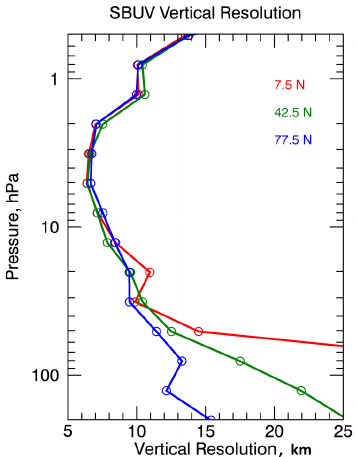
Fig. 9. SBUV vertical resolution estimated from the diagonal el- ements of the SBUV averaging kernels for three different lat- itude zones: tropics (5–10 ◦ N, SZA=27 ◦ ), mid-latitudes (40– 45 ◦ N, SZA=26 ◦ ), and high latitudes (75–80 ◦ N, SZA=57.5 ◦ ) for NOAA-17 for July 2004. The SBUV vertical resolution is about 6–7km between 10 and 2hPa and degrades above and below this range. The vertical resolution is similar for all latitude bands be- tween 20hPa and 0.5hPa. Below 20hPa the SBUV vertical resolu- tion in the tropics decreases sharply, due to fewer wavelengths used to retrieve ozone at small SZAs and the higher altitude of the ozone density peak. However, loss of vertical resolution does not affect the quality of total and partial column ozone retrievals in the tropics or elsewhere.